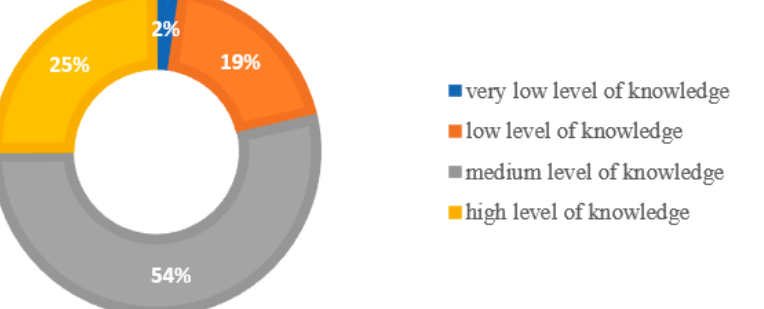
Figure 2. The level of knowledge of students from the Silesian province in the field of intestinal microbiota and colorectal cancer. Source: own study.